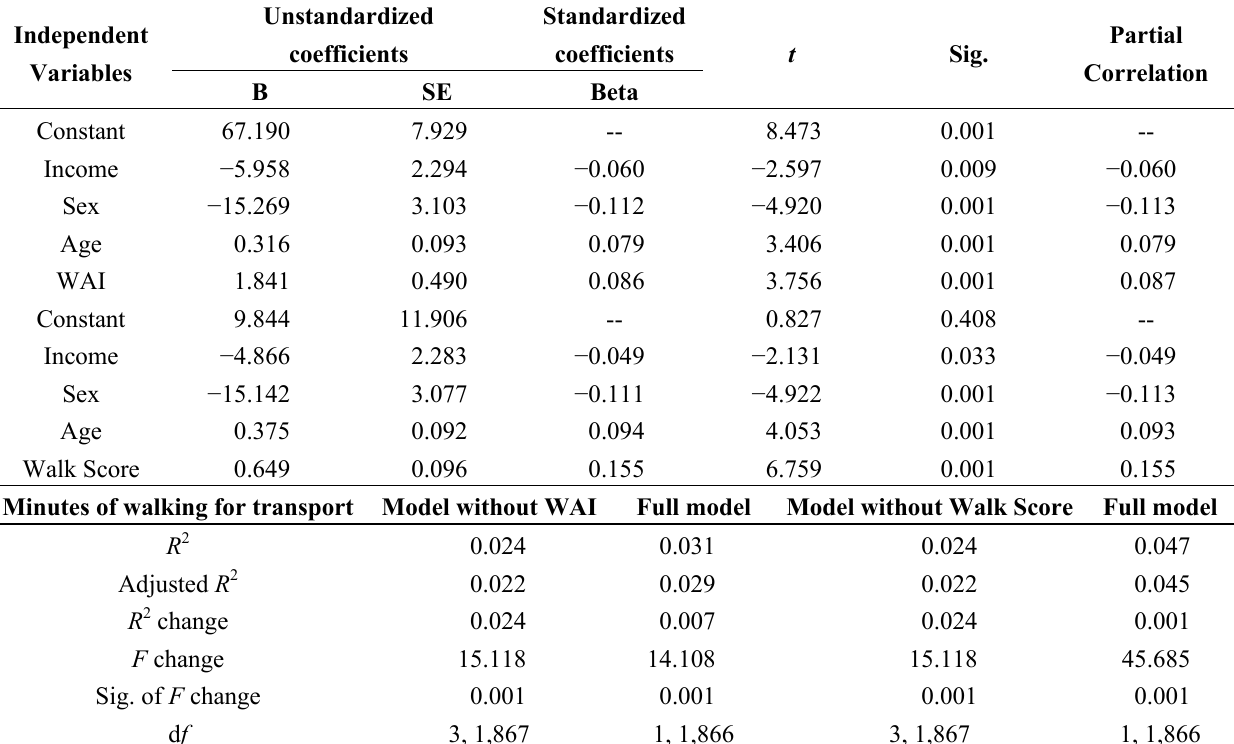
Table 4. Regression models for minutes of walking for transport per week with and without WAI and Walk